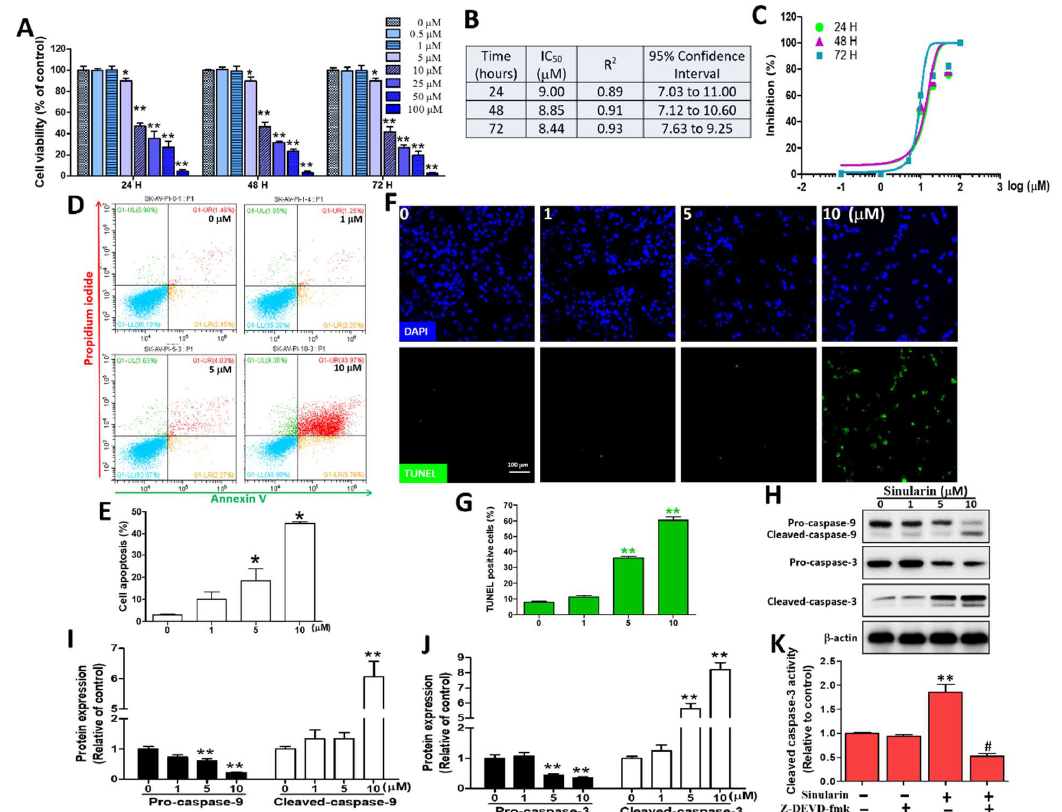
Figure 1. The sinularin induces cell viability, DNA fragmentation, and caspases 3/9 in SK-HEP-1 cells. ( A ) Quantification of cell viability using the MTT (3-(4,5-Dimethylthiazol-2-yl)-2,5-diphenyltetrazolium bromide) assay with sinularin at concentrations of 0, 0.5, 1, 5, 10, 25, 50, or 100 µ M for 24, 48, and 72 h, with results expressed as the percentage of cell viability compared to untreated cells. ( B ) Determination of the IC 50 values of sinularin after 24, 48, and 72 h. R 2 , representing coefficient of determination, and 95% confidence interval values were calculated. ( C ) Concentration-response S curves for sinularin after 24, 48, and 72 h of incubation. The cell proliferation inhibition response ( y -axis), and logarithmic concentration (x-axis) in the presence of different sinularin concentrations. R 2 and 95% confidence interval values of each concentration curve are shown in Figure 1B. ( D ) Flow cytometric analyses of apoptosis using Annexin-V/PI staining in the cells treated with sinularin after 24 h. The dot-plot quadrant diagram reflects the Annexin-V (x-axis; green) and PI (y-axis; red). The lower left quadrant shows the result for normal cells (Annexin V − /PI − ) and the upper left quadrant shows the result for necrotic cells (Annexin V − /PI+), while the lower right quadrant shows the result for early apoptotic cells (Annexin V+/PI − ) and the upper right quadrant shows the result for late apoptotic cells (Annexin V+/PI+). ( E ) Quantification of the Annexin V+/PI − (early apoptotic cells) and Annexin V+/PI+ (late apoptotic cells) regions. ( F ) Immunofluorescence showing apoptotic bodies in the SK-HEP-1 cells (marked in green) by the TUNEL-BrdU assay after being treated with 0, 1, 5, or 10 µ M of sinularin for 24 h. DAPI staining was used to observe cellular DNA/nuclei (blue) and was visualized under a fluorescence microscope (200 × magnification). ( G ) Quantification of TUNEL-positive cells. ( H ) A representative Western blot showing bands of caspases 3/9 in their pro- and cleavage forms, together with the housekeeper protein β -actin after being treated with sinularin for 24 h. Full, uncropped Western blot gels are shown in Supplementary Figure S2A. ( I ) Pro- and cleaved caspase 9 levels quantified with densitometry analysis using ImageJ software after normalized with the β -actin level. ( J ) The pro- and cleaved caspase 3 levels quantified with densitometry analysis using ImageJ software after being normalized with the β -actin level. ( K ) After prior incubation with Z-DEVD-fmk (5 µ M) for 2 h, SK-HEP-1 cells were treated without or with sinularin (10 µ M) for an additional 24 h and then examined by cleaved caspase-3 kit and ELISA read analysis. Each bar represents the mean ± SE of three independent experiments. The results were analyzed using Student’s t -test and ANOVA to determine the significance. * p < 0.05 and ** p < 0.01 relative to the control (sinularin-untreated cells), and # p < 0.01 relative to the experimental group with 10 µ M of sinularin